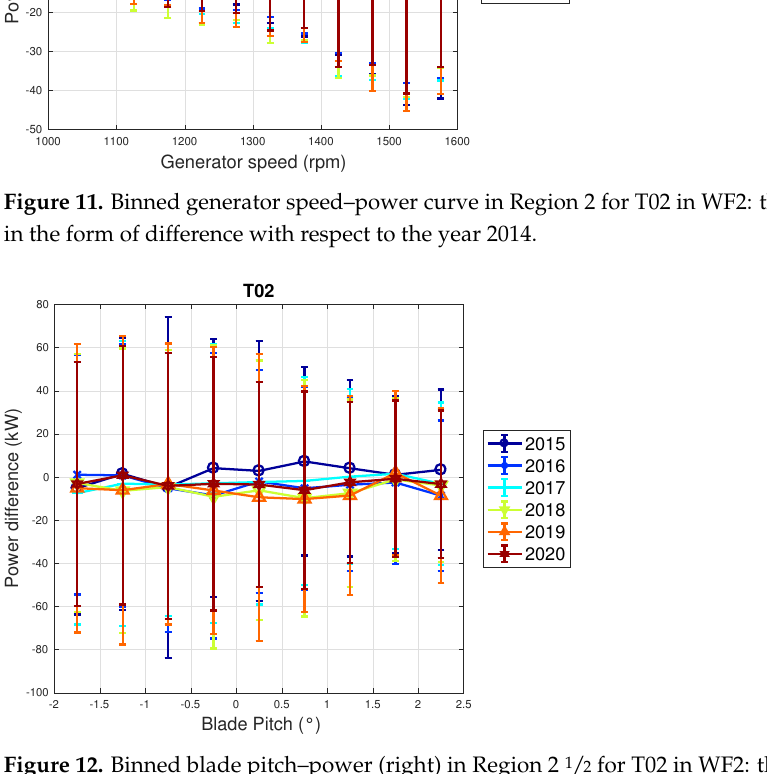
Figure 12. Binned blade pitch–power (right) in Region 2 1 / 2 for T02 in WF2: the curves are reported in the form of difference with respect to the year 2014.